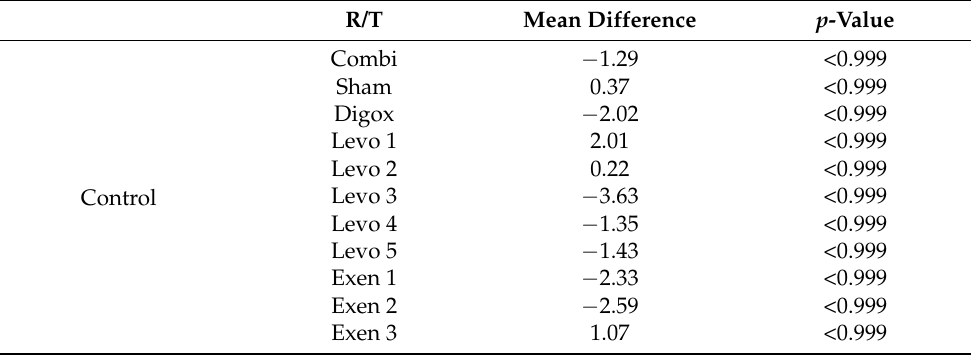
Table 15. Pairwise comparisons for R/T among